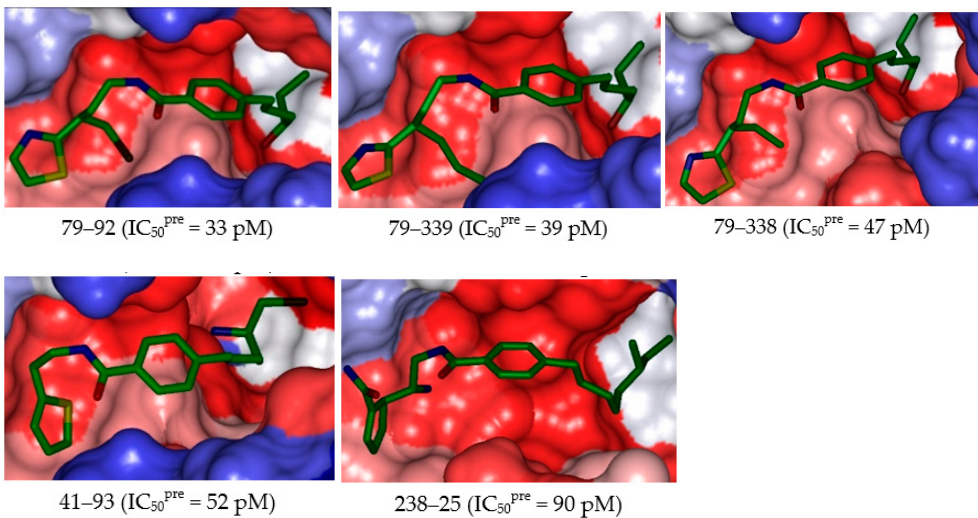
Figure 8. Surface of the active site of Mt InhA with bound 5 best active designed BHMB analogs. The binding site surface is colored according to residue hydrophobicity: red = hydrophobic, blue = hydrophilic, and white = intermediate.